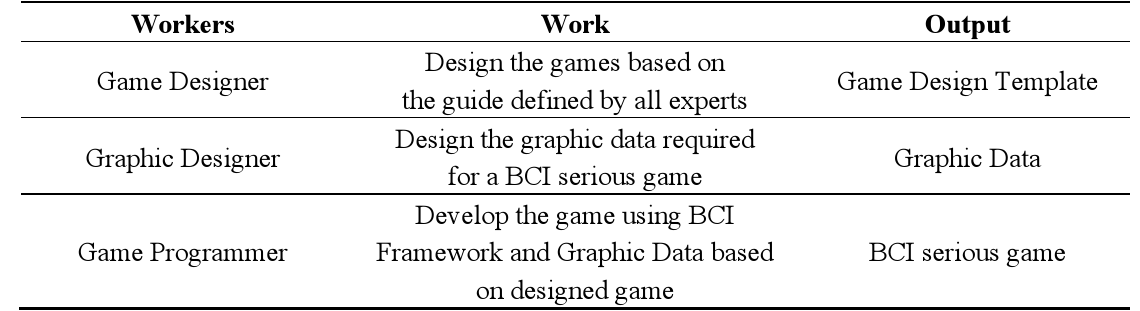
Table 3. Output from game developers.